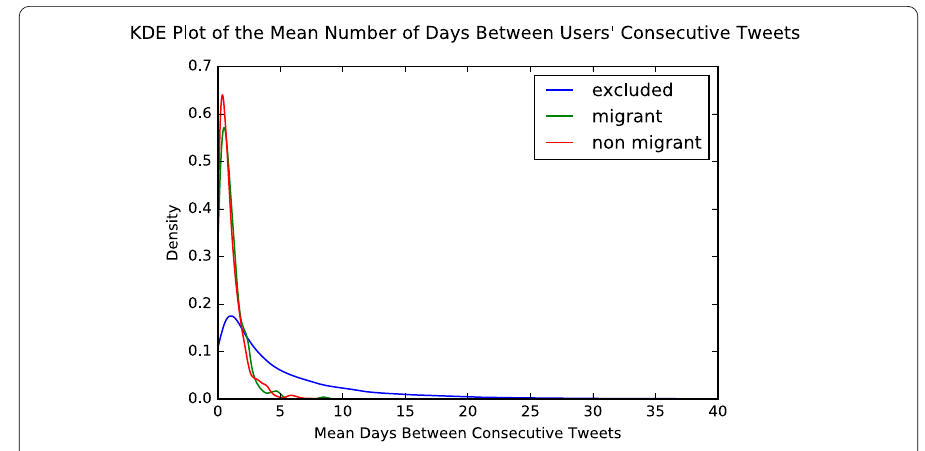
Figure 2 A KDE of the average number of days between tweets for those users that were excluded through our 30 day criteria, those that were eventually classified as migrants through either of the two methods, and those that were not classified as migrants. The x axis has been constrained to 40 tweets maximum to reduce graph scale, the max value extends to 140 along the same horizontal